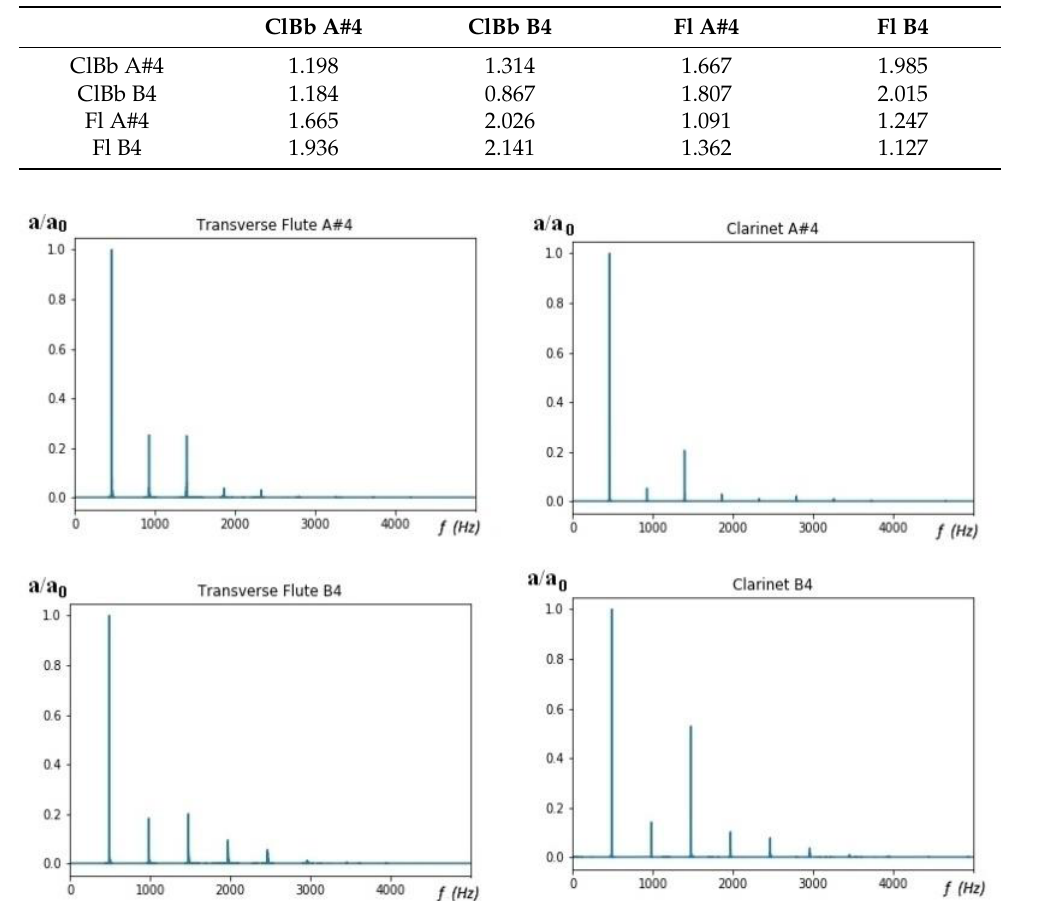
Figure 7. Comparison of the normalized FFTs of the sounds A#4 and B4 (rows) for Flute and Clarinet (columns). The intensities are normalized with respect to the amplitude ( a 0 ) of the fundamental frequency.